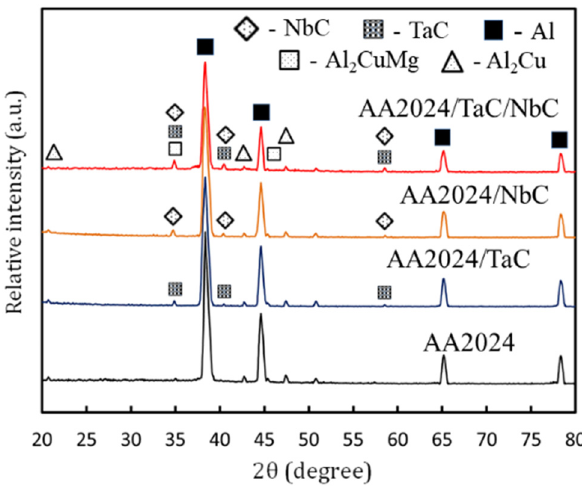
Figure 10: Thermal expansion behavior of AA2024 and its